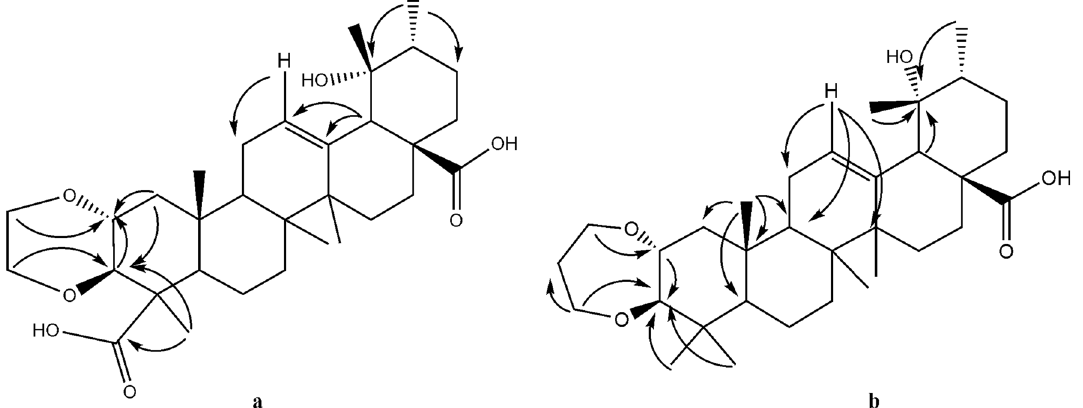
Figure 2. Key HMBC correlations. a = compound 1 ; b = compound